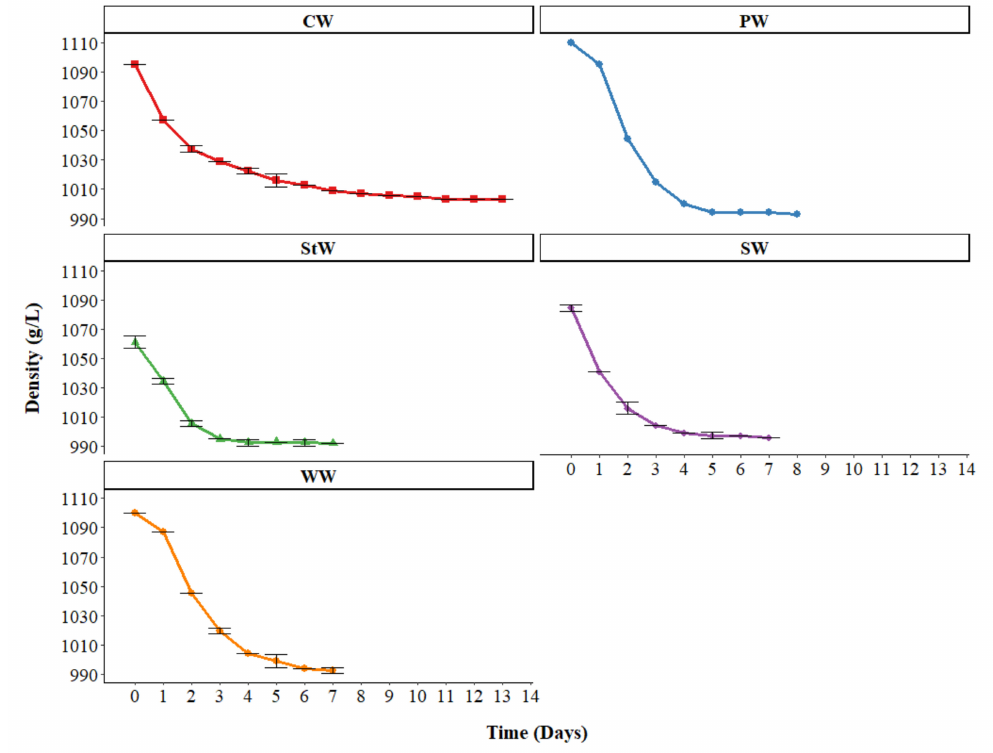
Figure 2. The fermentation kinetics of grape-musts in 2020 harvest (an average of two ferments except for PW; horizontal black bars indicate the standard deviation; see Table 1 for sample